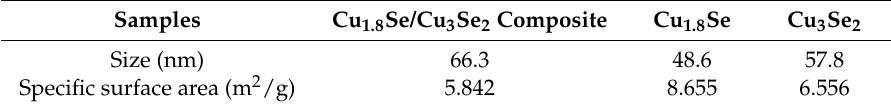
Figure 1. X-ray diffraction profiles of as-prepared copper selenides, ( a ) Cu 3 Se 2 , ( b ) Cu 1.8 Se/Cu 3 Se 2 composite, ( c ) Cu 1.8 Se. composite, ( c ) Cu 1.8 Se. Table 1. The BET (Brunauer-Emmett-Teller) specific surface area of different Table 1. The BET (Brunauer-Emmett-Teller) specific surface area of different samples.